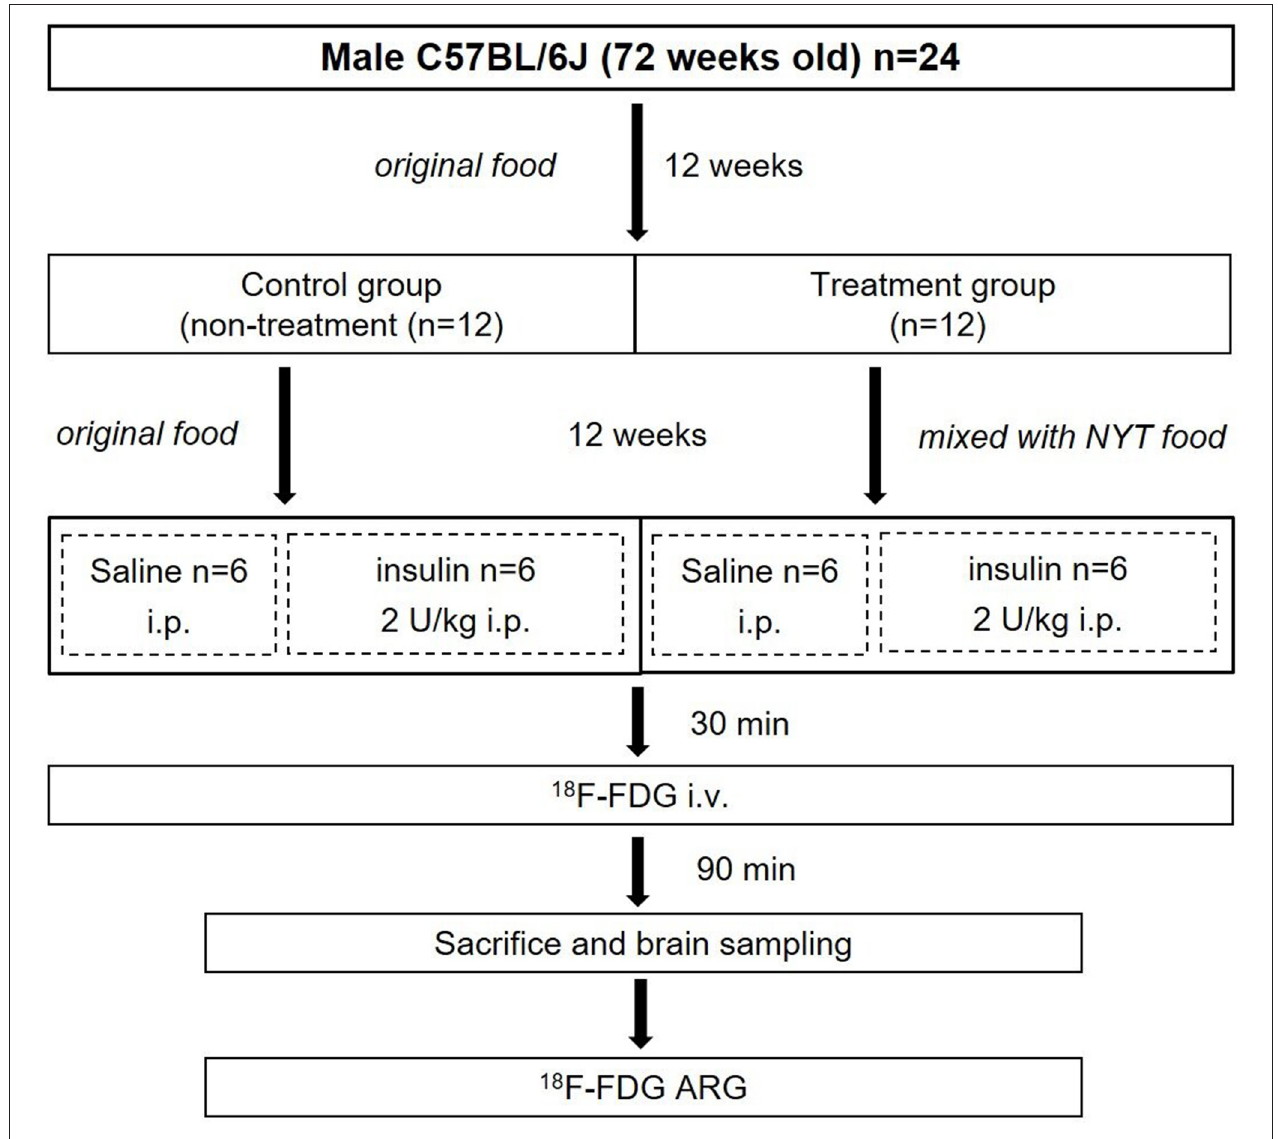
FIGURE 1 | Experimental